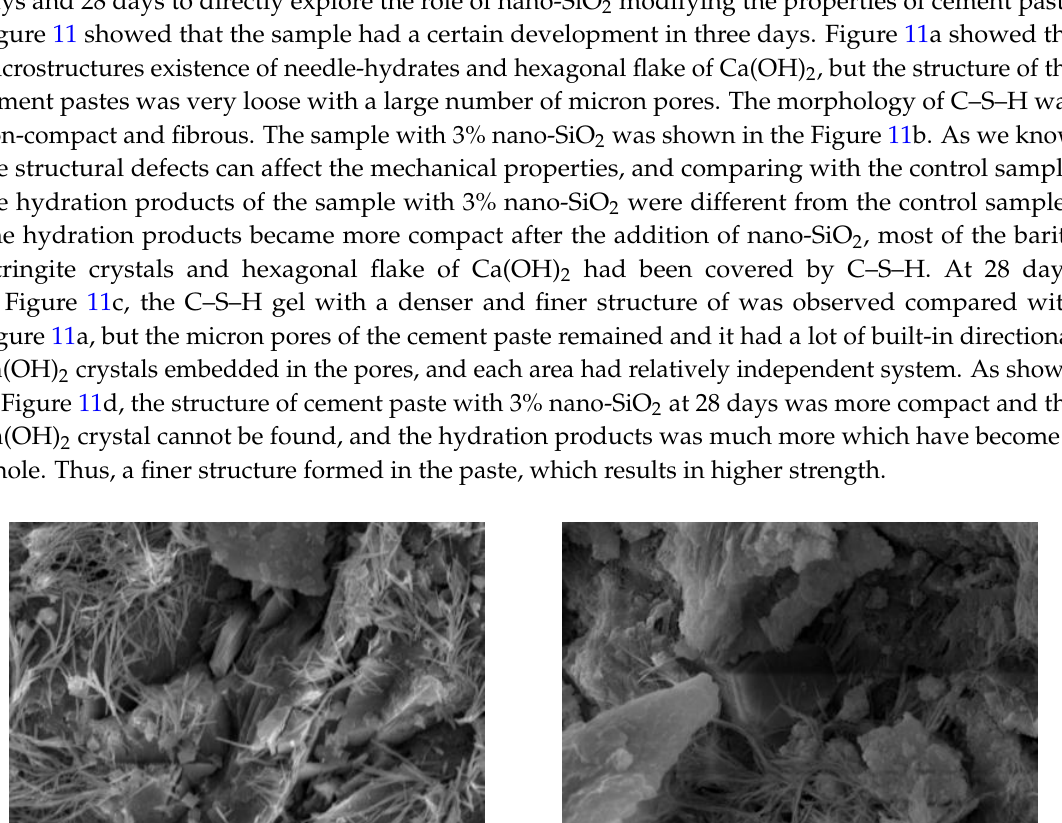
2 at difference ages. Figure 10. The mass loss of Ca(OH)